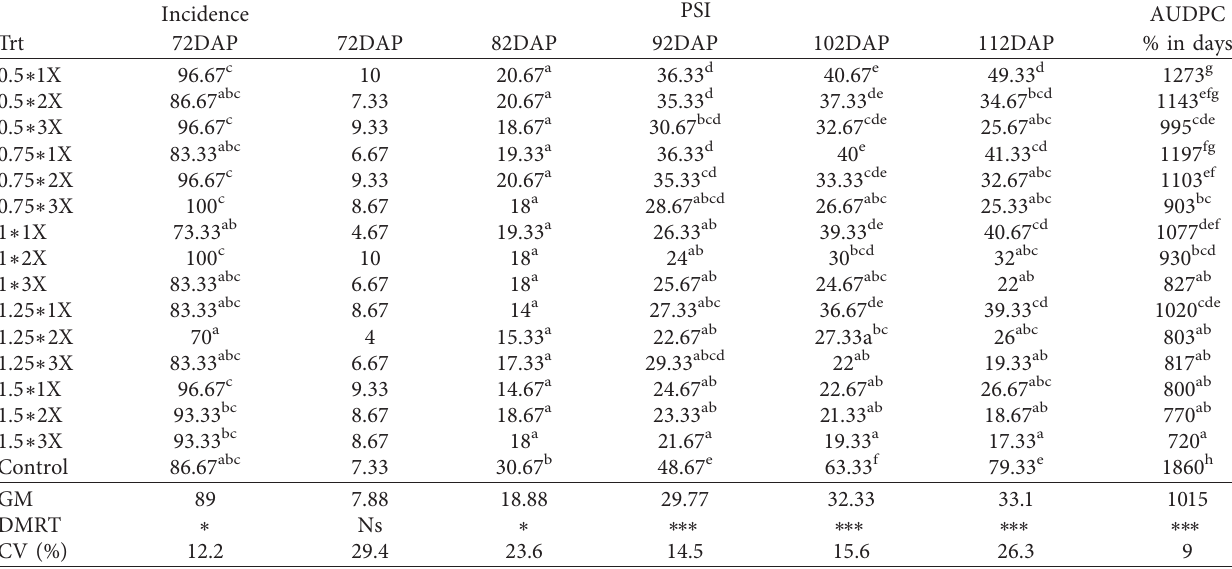
Table 2: The mean of garlic rust disease incidence, PSI at d/ t days, and AUDPC data at Kabe in 2019 cropping season. Incidence PSI AUDPC Trt 72DAP 72DAP 82DAP % in days